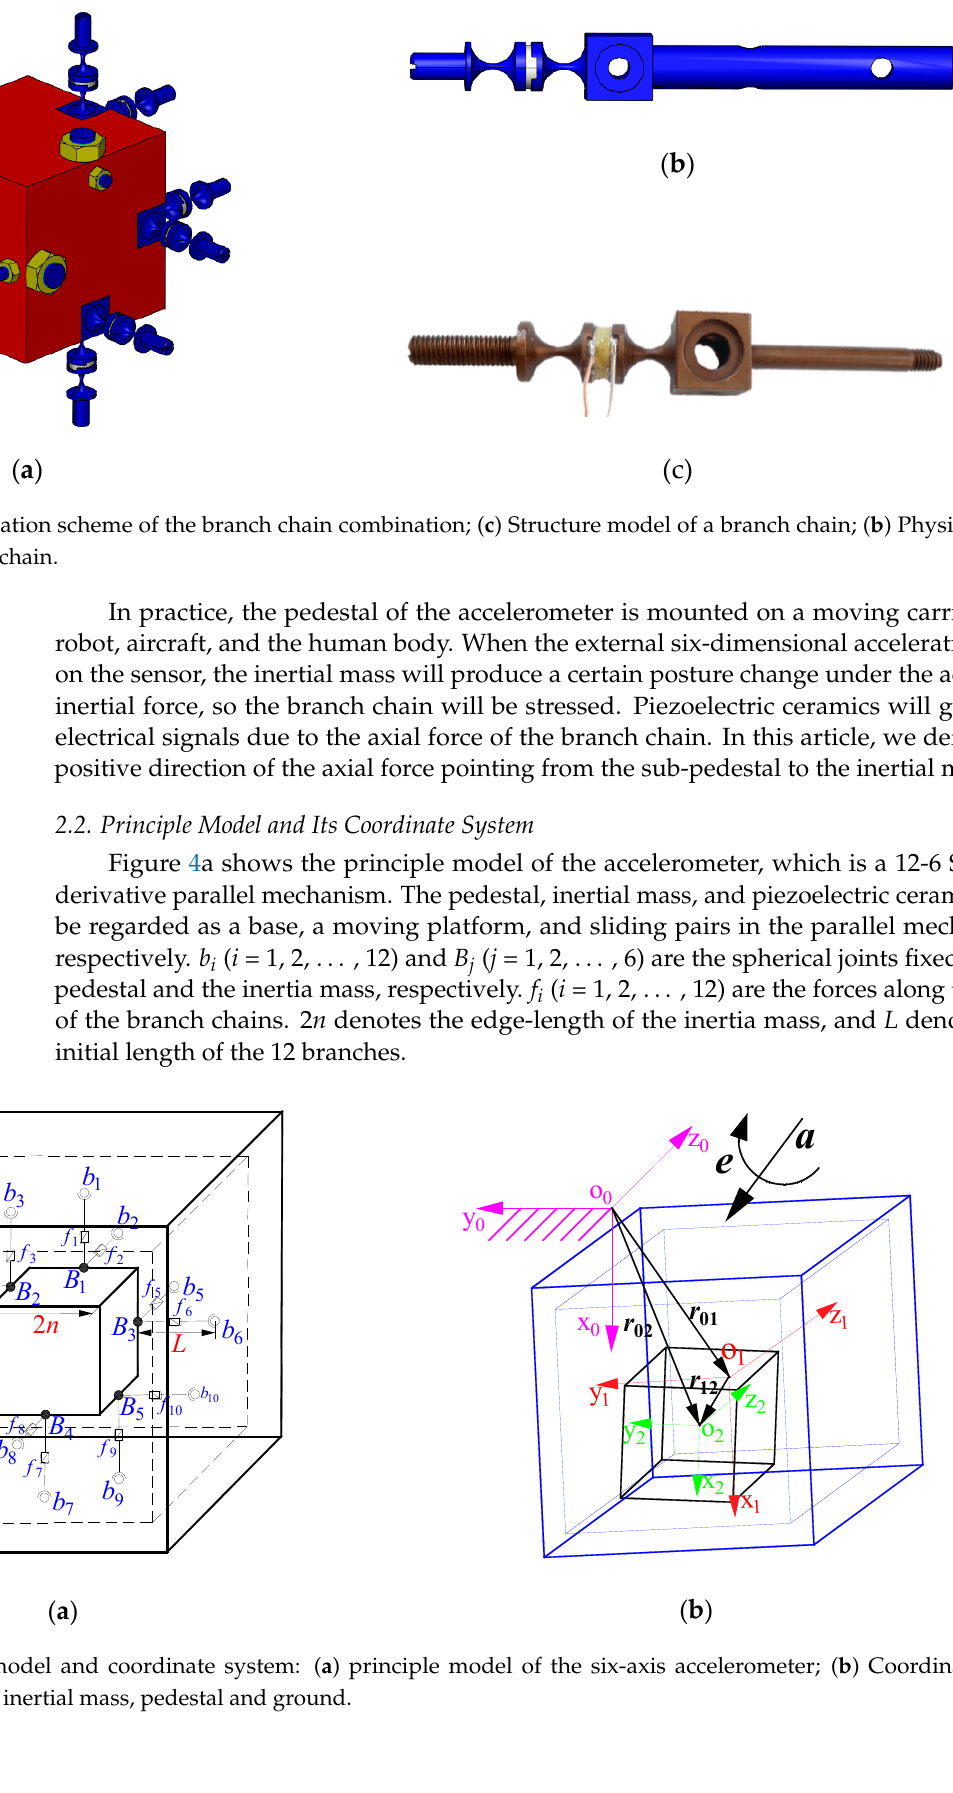
Figure 4. Principle model and coordinate system: ( a ) principle model of the six-axis accelerometer; ( b ) Coordinate rela- tionships between inertial mass, pedestal and ground.